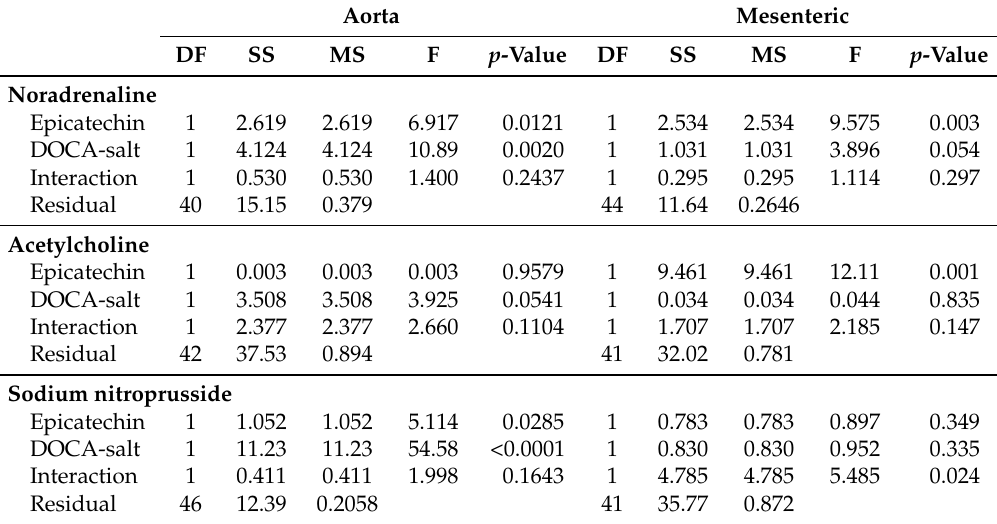
Table 3. Two-factor ANOVA for vascular EC 50